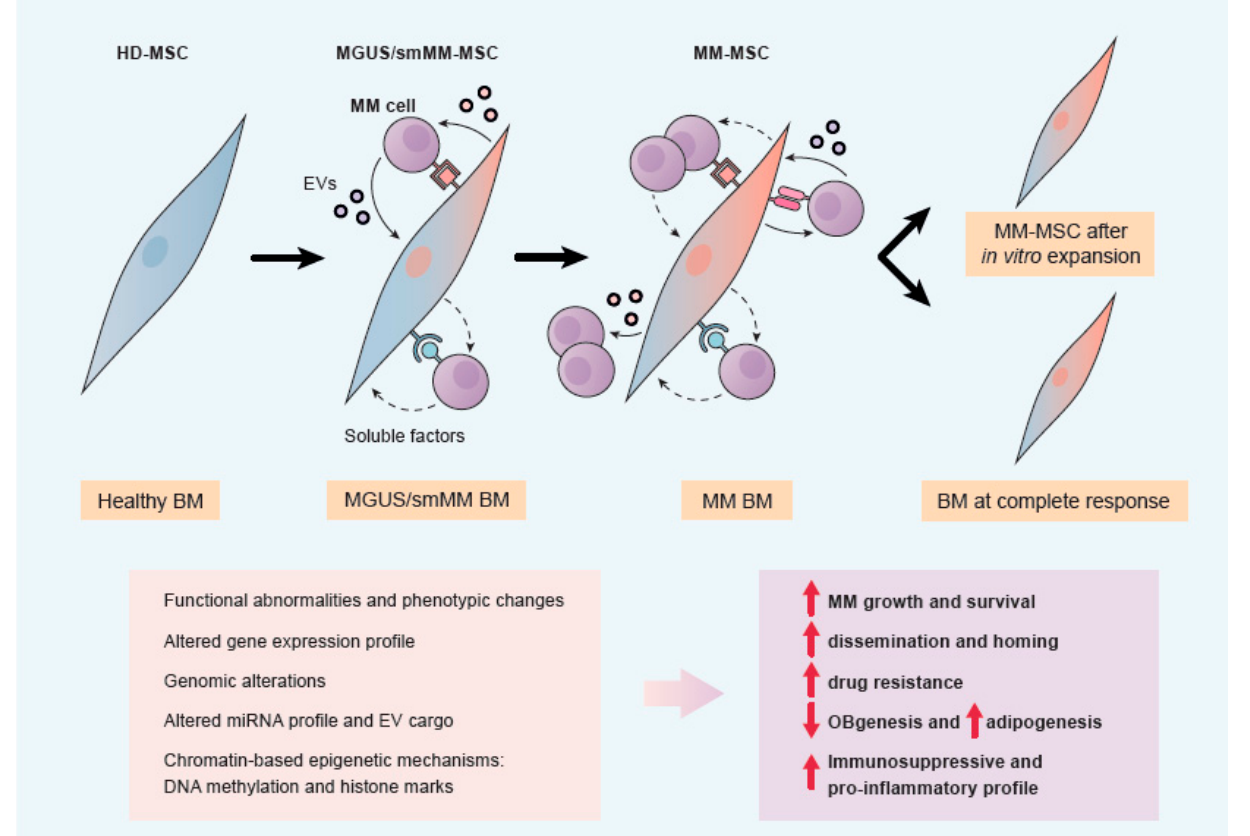
Figure 1. Hypothetical transition from HD-MSCs to myeloma MM-MSCs mediated by interaction with MM cells. Interaction of MGUS and smMM plasma cells with MSCs is considered an initiating event. Direct contact of myeloma cells and MSCs, together with soluble factors (dashed arrows) and EVs (solid arrows) induce various layers of modifications in MSCs (phenotypic, gene expression, genomic, miRNA, and epigenetic), contributing to the transition from HD- to MM-MSCs and to myeloma pathology. Epigenetic modifications may be responsible for maintenance of MM-MSC features in absence of myeloma cell interactions.